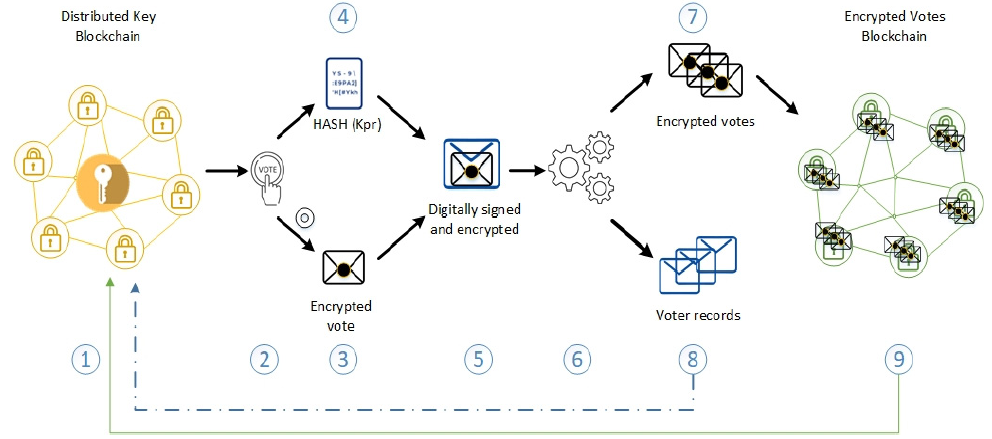
Figure 2. Proposed